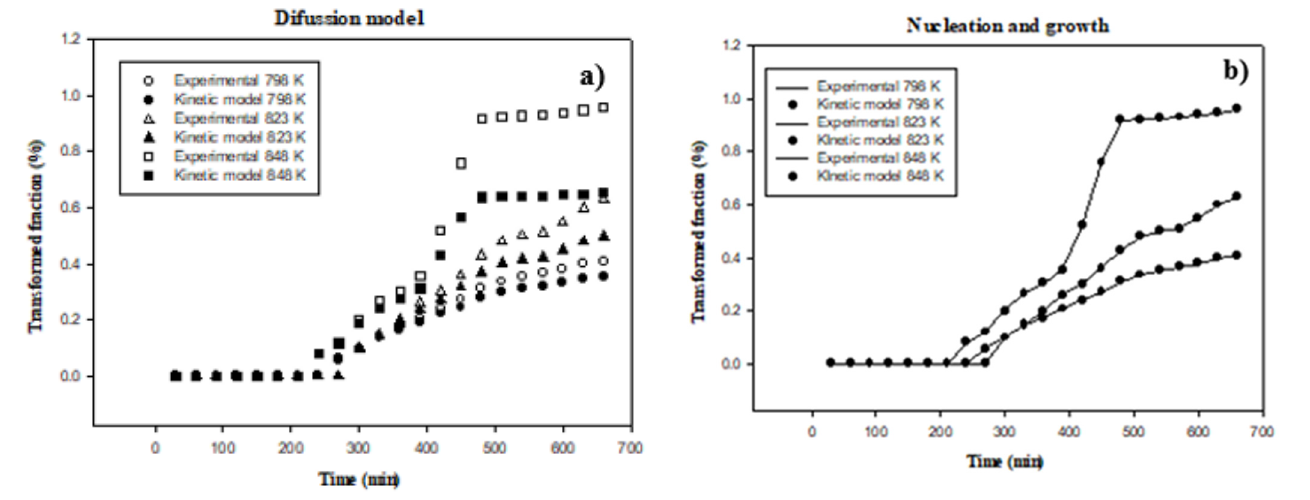
Figure 7. Comparison of the behavior of the experimental data with the description of the g( θ ) function for different homogenization temperatures for the mathematical models of Diffusion ( a ) and nucleation and growth ( b ).